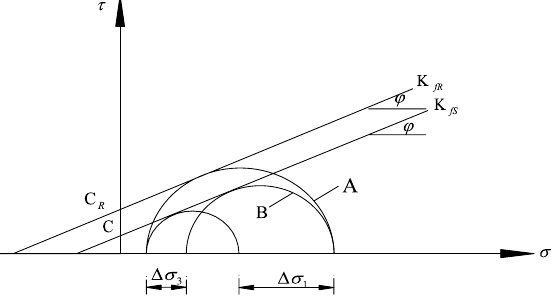
Figure 5. Mohr’s stress circle of surrounding rock reinforcement